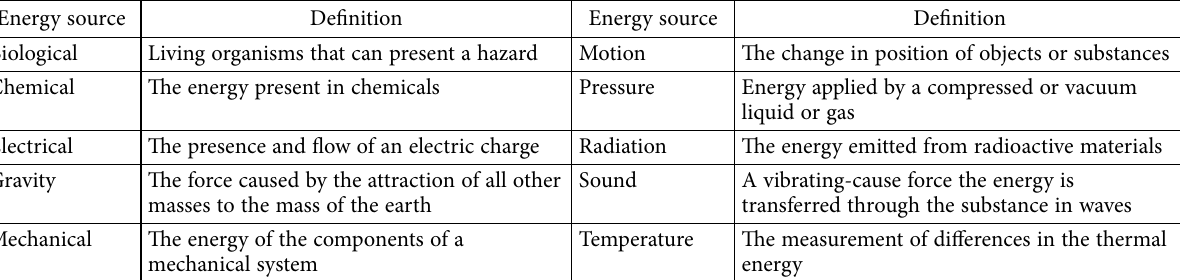
Table 1. Energy sources, adapted from Chen et al.